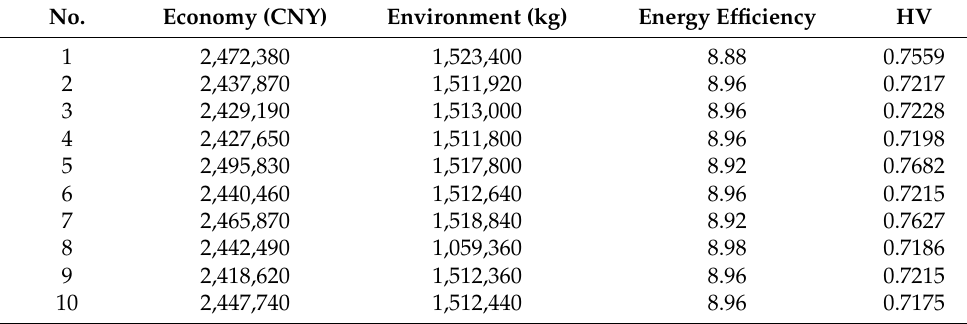
Table 4. Pareto optimal solutions of the NSGA-III algorithm for different